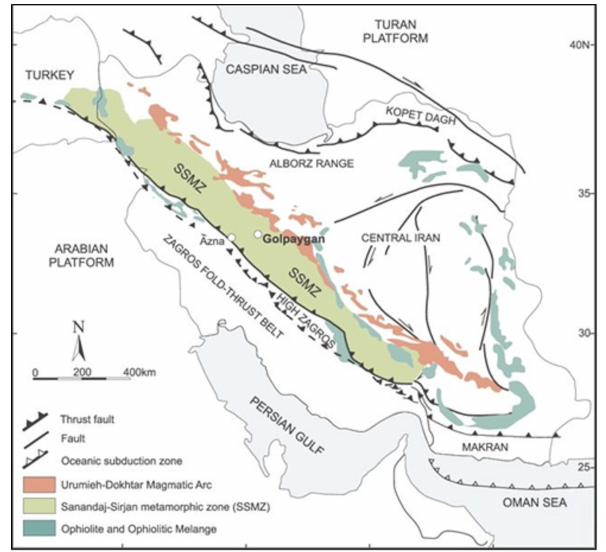
Figure 1. Schematic tectonic map of Iran (Alavi,